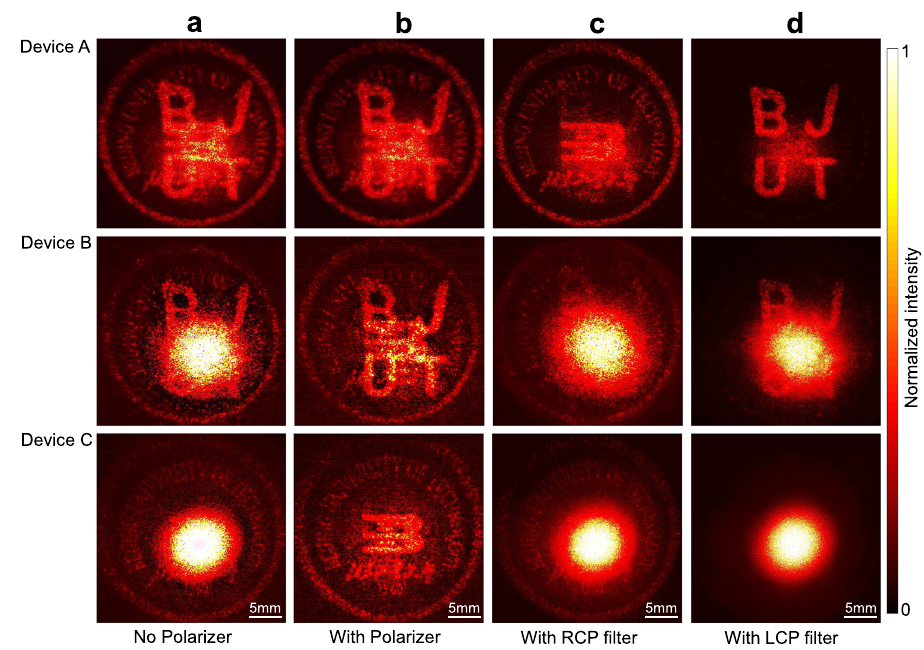
Fig. 3 | Superposition of different beam pro fi les of the spin-decoupled holo- graphic VCSEL, of which the polarization selectivity of each channel can be used for encryption purpose. In this example, two sets of meta-atoms with dif- ferent dimensions were employed to construct metasurfaces with relatively high ef fi ciency (Device A) and low ef fi ciency (Device B and Device C). Meanwhile, a broad diverging beam coming from the uncontrolled co-polarization channel was